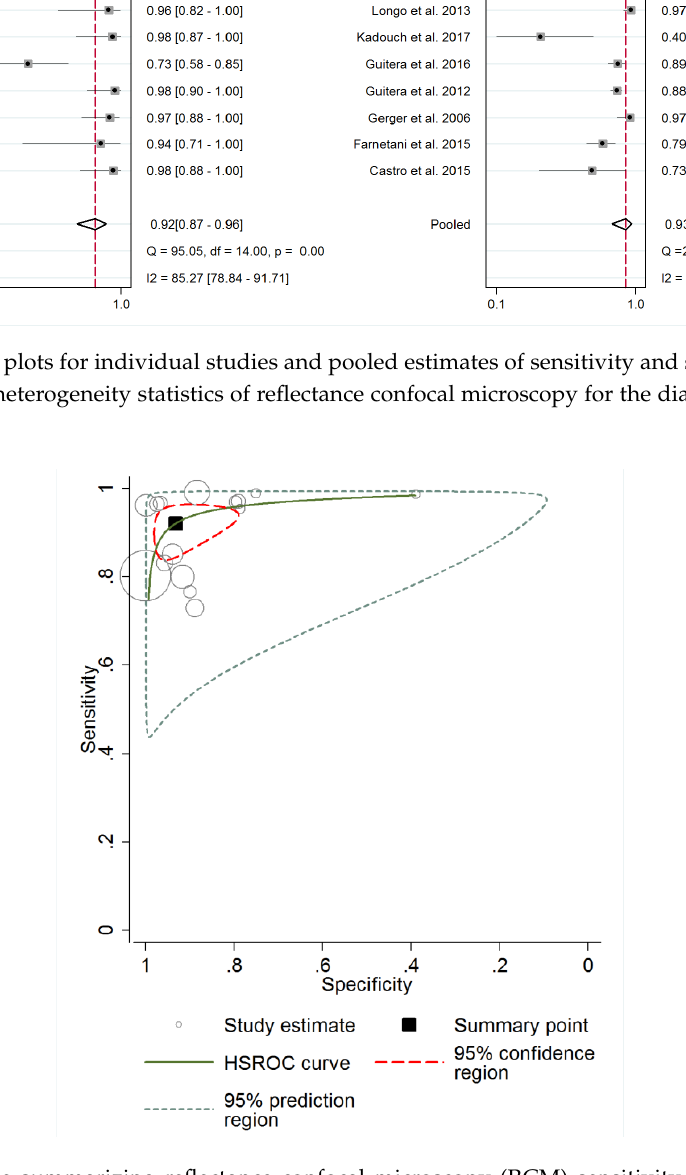
Figure 5. Curve summarizing reflectance confocal microscopy (RCM) sensitivity and specificity forBCC diagnosis.